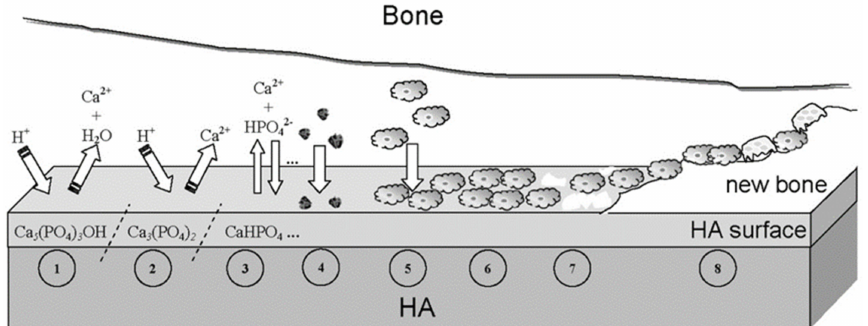
Figure 14. A schematic diagram representing the phenomena that occur on the HA surface after implantation: (1) beginning of the implant procedure, where a solubilization of the HA surface starts; (2) continuation of the solubilization of the HA surface; (3) the equilibrium between the physiological solutions and the modified surface of HA has been achieved (changes in the surface composition of HA do not mean that a new phase of DCPA or DCPD forms on the surface); (4) adsorption of proteins and/or other bioorganic compounds; (5) cell adhesion; (6) cell proliferation; (7) beginning of a new bone formation; (8) new bone has been formed. Reprinted from Ref. [651] with